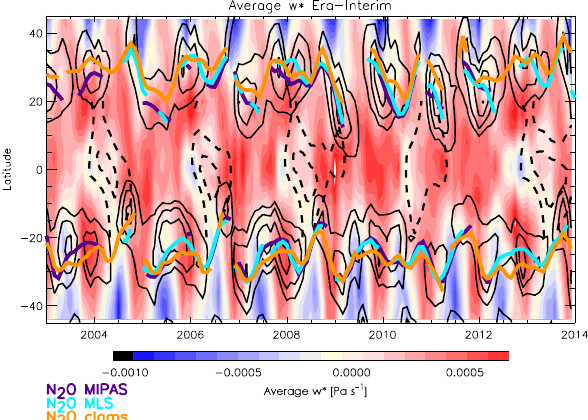
Figure 3. Positions of the subtropical transport barriers over time at 600K compared to other dynamical quantities providing a mea- sure for the position of the tropical pipe: the purple, turquoise, and orange solid lines provide the positions of the subtropical trans- port barriers from MIPAS, MLS, and CLaMS data, respectively, derived with the method of Palazzi et al. (2011); the colour coding indicates the values of w ∗ (see colour bar); the latitude regions of maximum meridional tracer gradients are indicated as black contour lines. Black dashed lines enclose the regions of positive zonal-mean zonal wind (QBO positive phases).